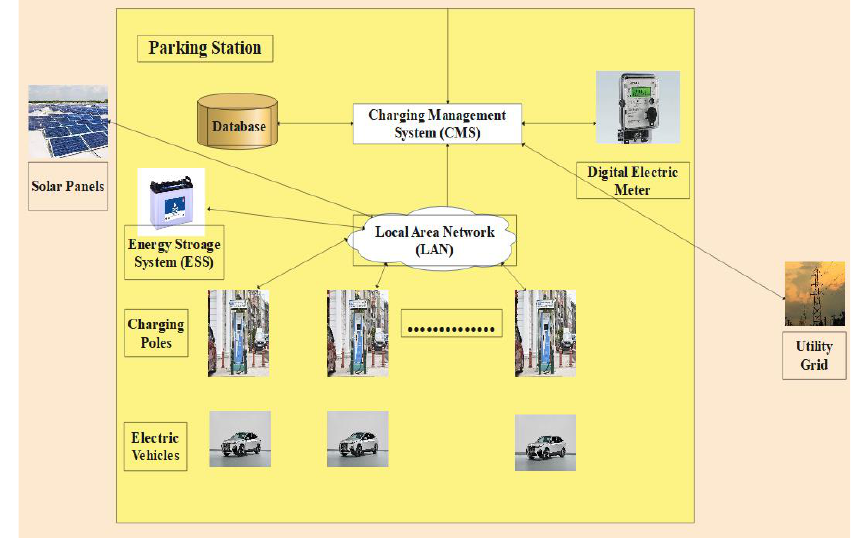
Figure 2. Brief diagram of overall process. The overall process is separated into three